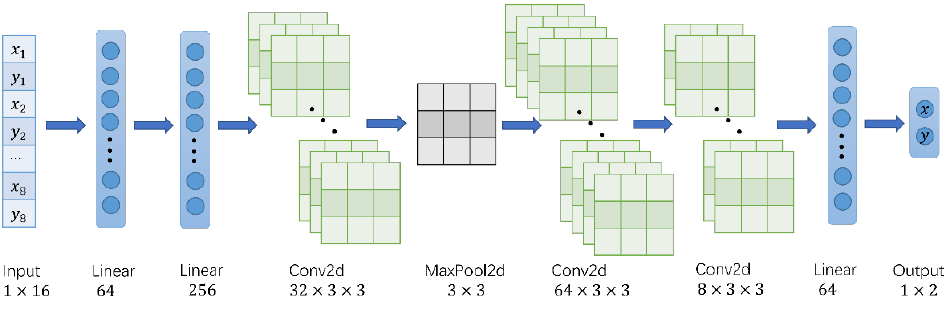
Figure 2. Neural network structure